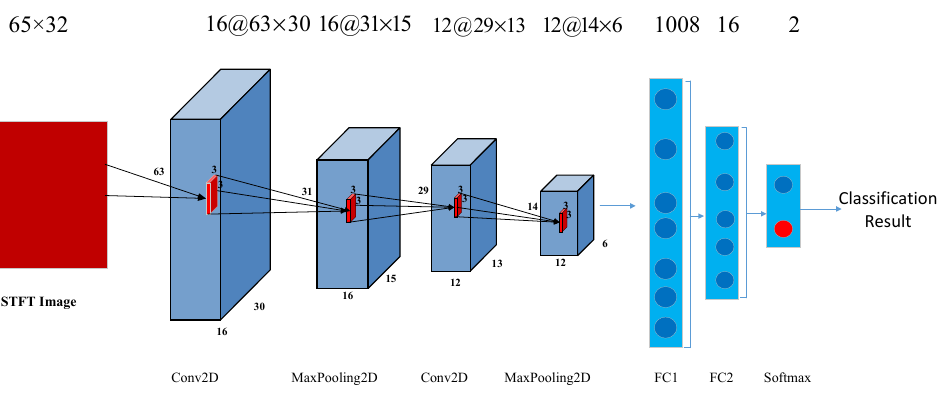
Figure 4. Binary classification with the approach of STFT+2D-CNN.